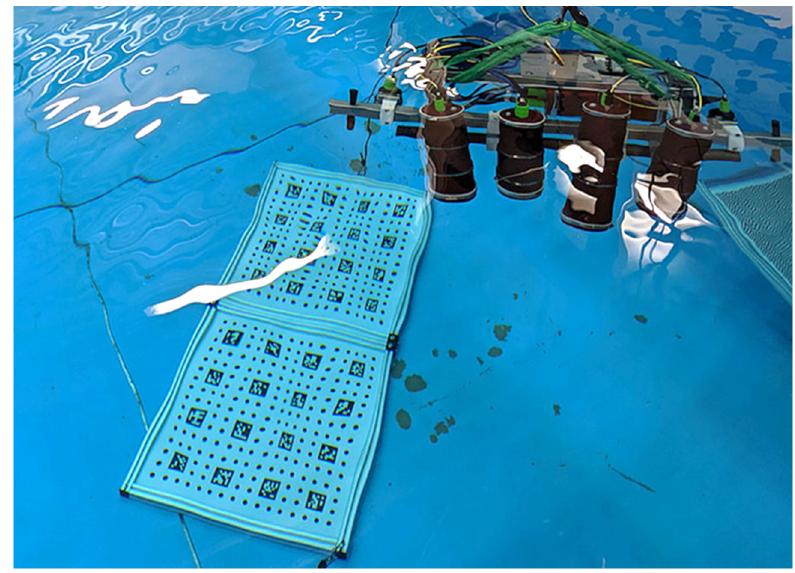
Figure 1. Scanning system in the water basin and marker boards with ArUco markers and circle patterns on the ground of the basin at calibration.